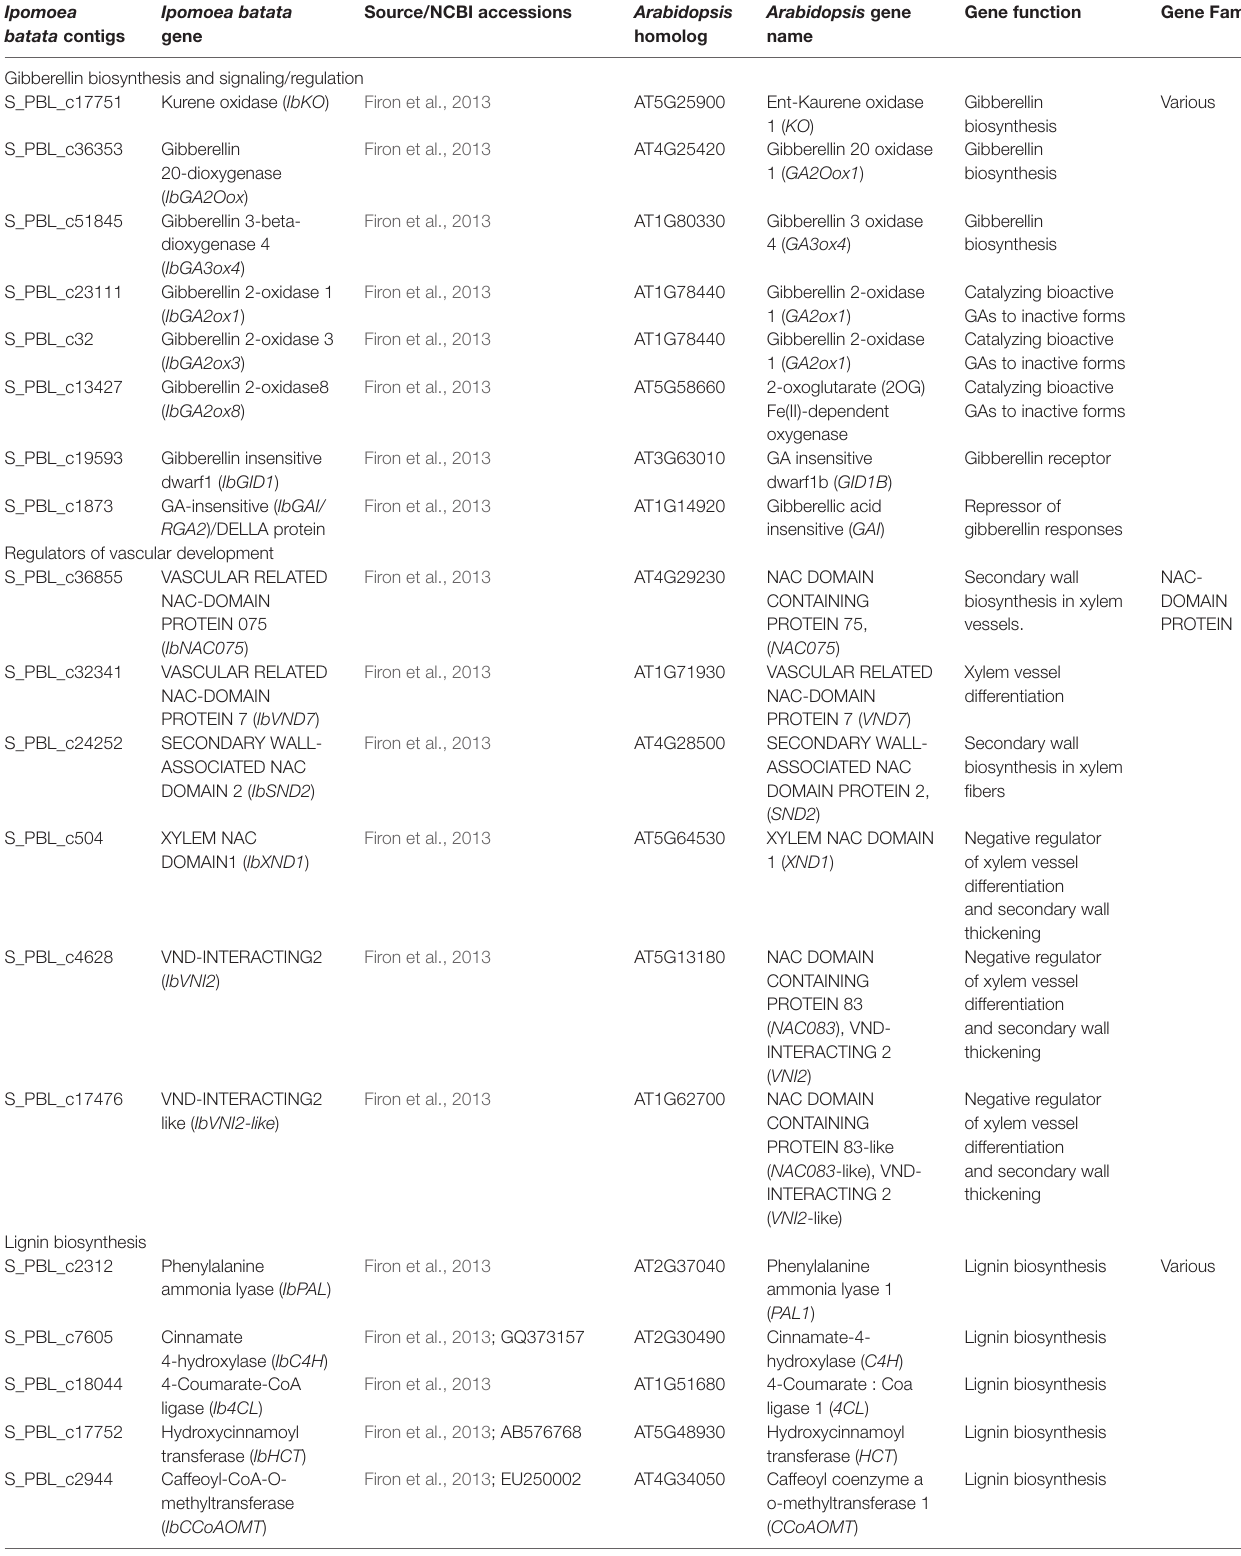
TaBLe 1 | Sweetpotato ( Ipomoea batata) Georgia Jet orthologues/genes investigated in our study. Ipomoea batata